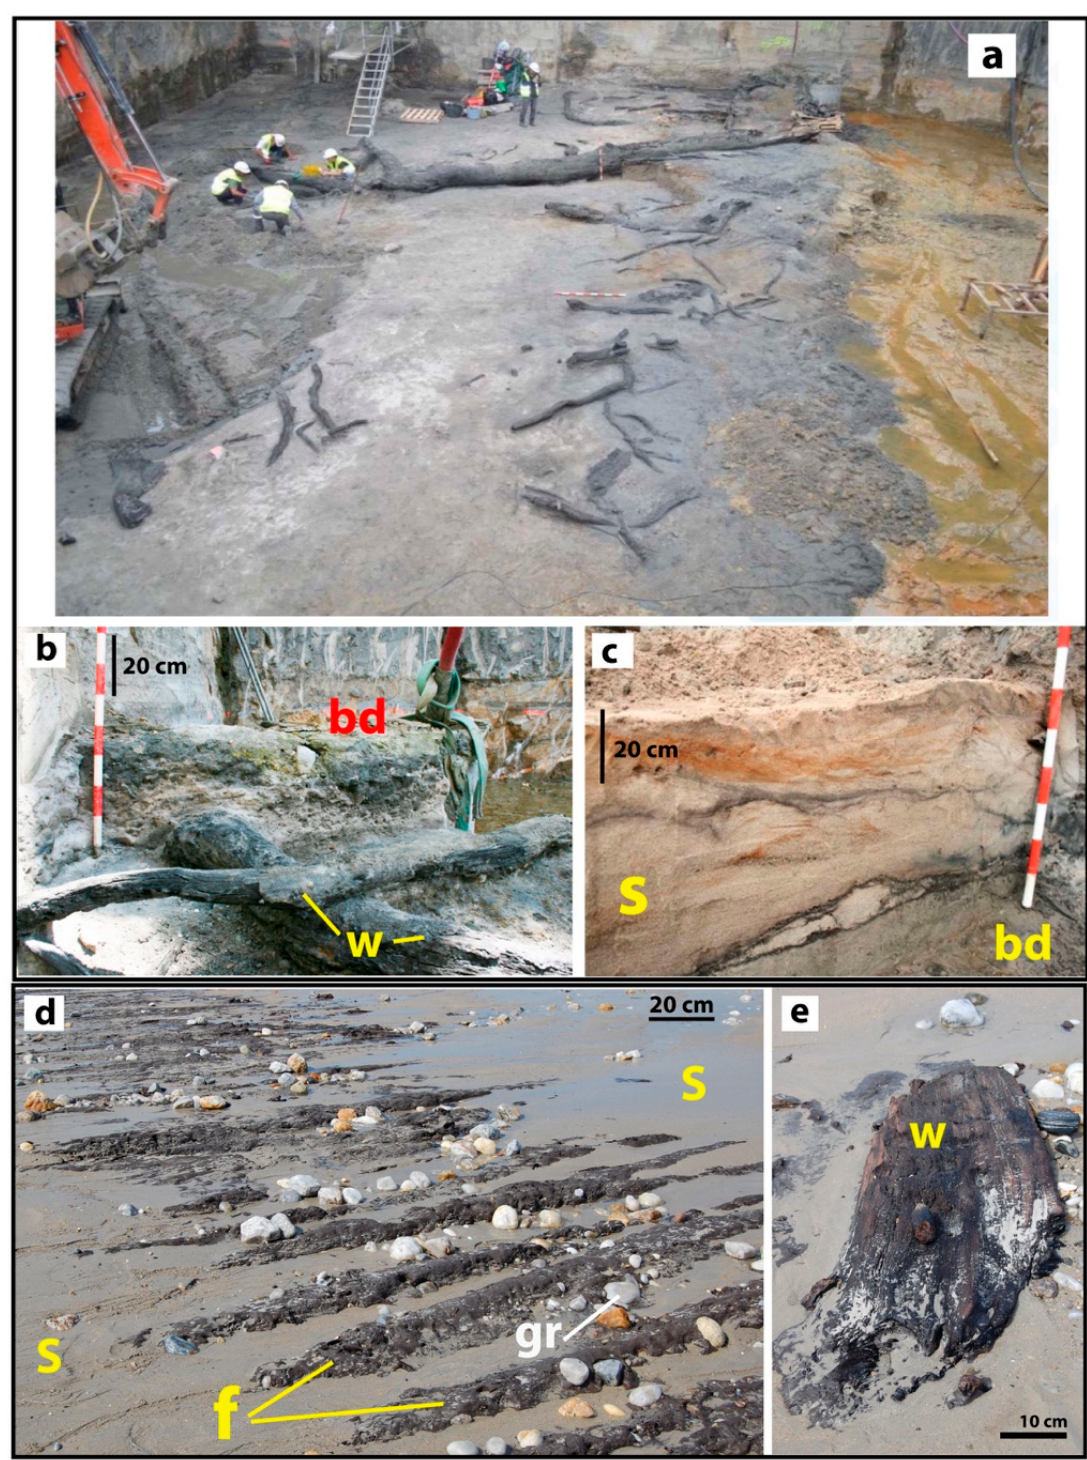
Figure 11. Submerged forests buried by Holocene dunes in the Ria de Vigo. ( a – c ) Submerged forest of Arenal (Vigo, Pontevedra) located at − 13 m (bpsl) under a dune of over 10 m. ( b ) W: woody remains and whole trunks; bd: base of dune. ( c ) Detail of the aeolian sands from the dune of Arenal; S: aeolian sands (modified from [29]). ( d , e ) Submerged forest in Patos Beach (Nigran, Pontevedra); f: forest soil with roots in living position; gr: gravels; s: sand beach; w: wood remains.